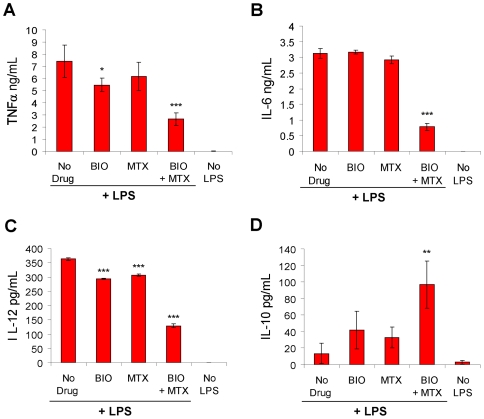
DHFR inhibition enhances pro and anti-inflammatory cytokine production by inhibition of GSK3.Cytokine production in PBMCs preincubated for 1 hr in medium only (No Drug), 5 nM BIO (GSK3i), 10 nM methotrexate (MTX), or the combination of the two compounds (BIO + MTX) and then stimulated with 300 ng/ml LPS for 20 hr. No LPS controls are shown on the far right of each graph for reference. Cell free supernatants were analyzed by ELISA for production of TNFα (A), IL-6 (B), IL-12 (C), or IL-10 (D). *, P<0.05, **, P<0.01, and ***, P<0.001, compared with LPS alone. Results represent the mean±SD of 6 replicate wells for each sample. The results shown are representative of three separate experiments.